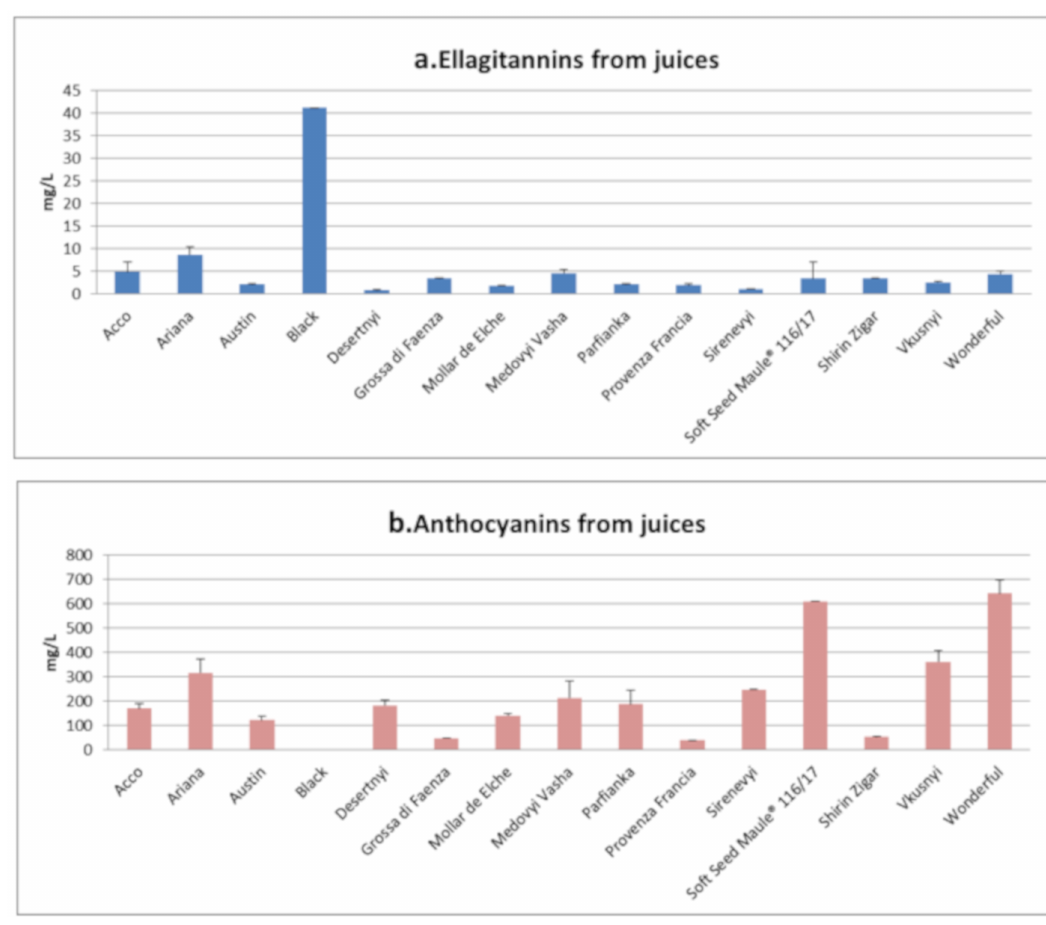
Figure 2. Ellagitannins ( a ) and anthocyanins ( b ) from juices. Ellagitannins content is expressed as mg of ellagic acid on g of dried matter (all the detected ellagitannins showed λ MAX close to 370 nm). The content of anthocyanins is expressed as mg of oenin on g of dried